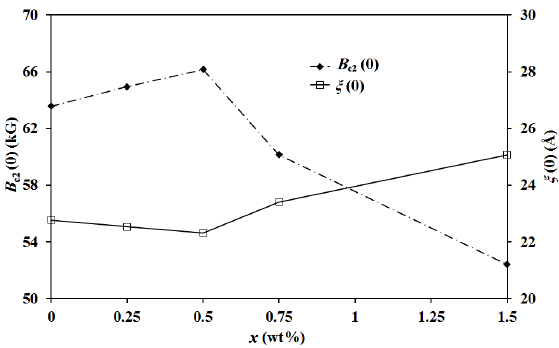
Fig. 10 Plots of 2223 samples.